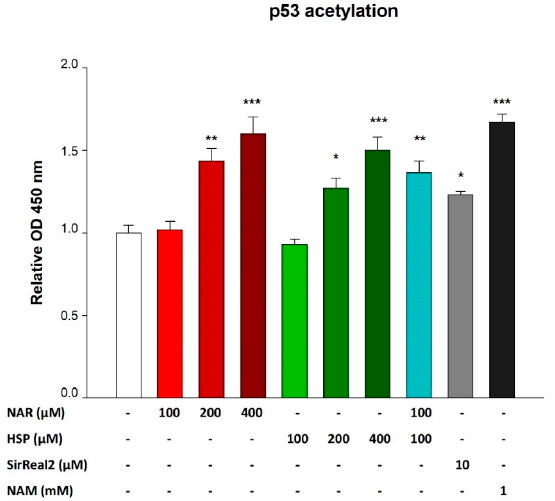
Figure 7. Relative levels of acetylated p53 after treatment for 24 h with NAR (red bars), HSP (green bars), and their combination (light blue bar) in THP-1 cells. Specific and non-specific SIRT2 inhibitors, SirReal2 (gray bar) and NAM (black bar), respectively, were used as positive controls. Protein levels of acetylated p53 were quantified by an ELISA. Data are expressed as fold change with respect to controls (untreated cells) and are the mean ± SEM of three independent experiments performed in triplicate ( n = 9). * p < 0.05, ** p < 0.01, and *** p < 0.001 vs. CTRL. 3.6. NAR and HSP Modulated SIRT2, p21, and Cyclin E1 but Not p53 mRNA Levels in THP-1 Cells